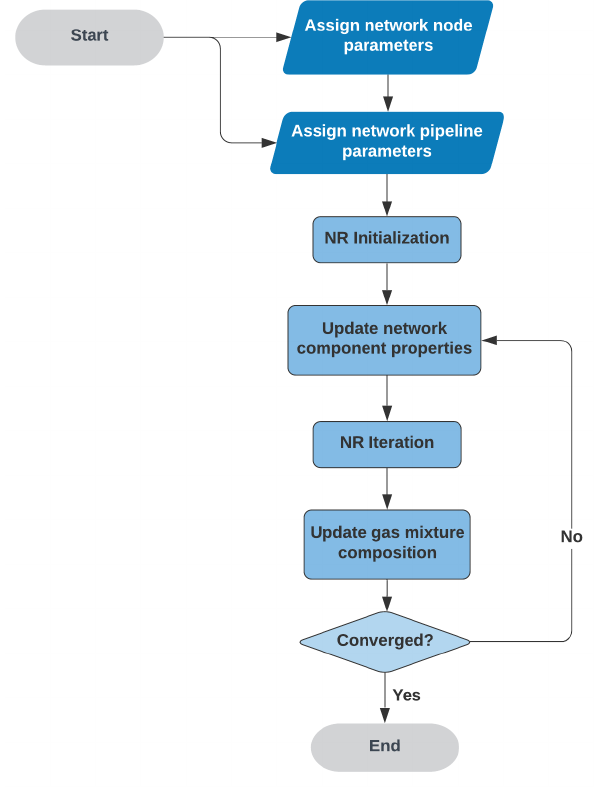
Figure 1. Flow chart of the solving